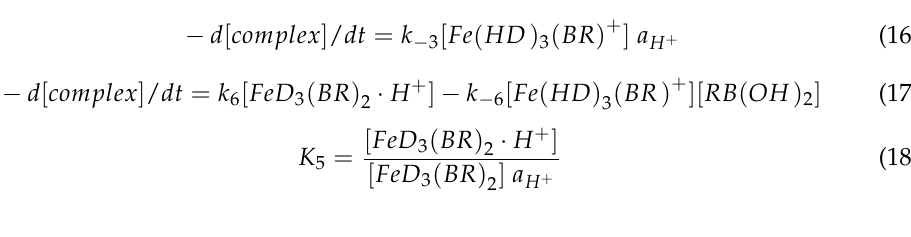
Figure 12. Example of a determination of the decomposition reaction rate constant k d clathrochelate FeOx 3 (BCH 3 ) 2 ( 5 ) at its concentration 4.6 × 10 − 5 mol L − 1 in 2.6 M solution of sulfuric acid ( a H + = 0.019 mol L − 1 ).